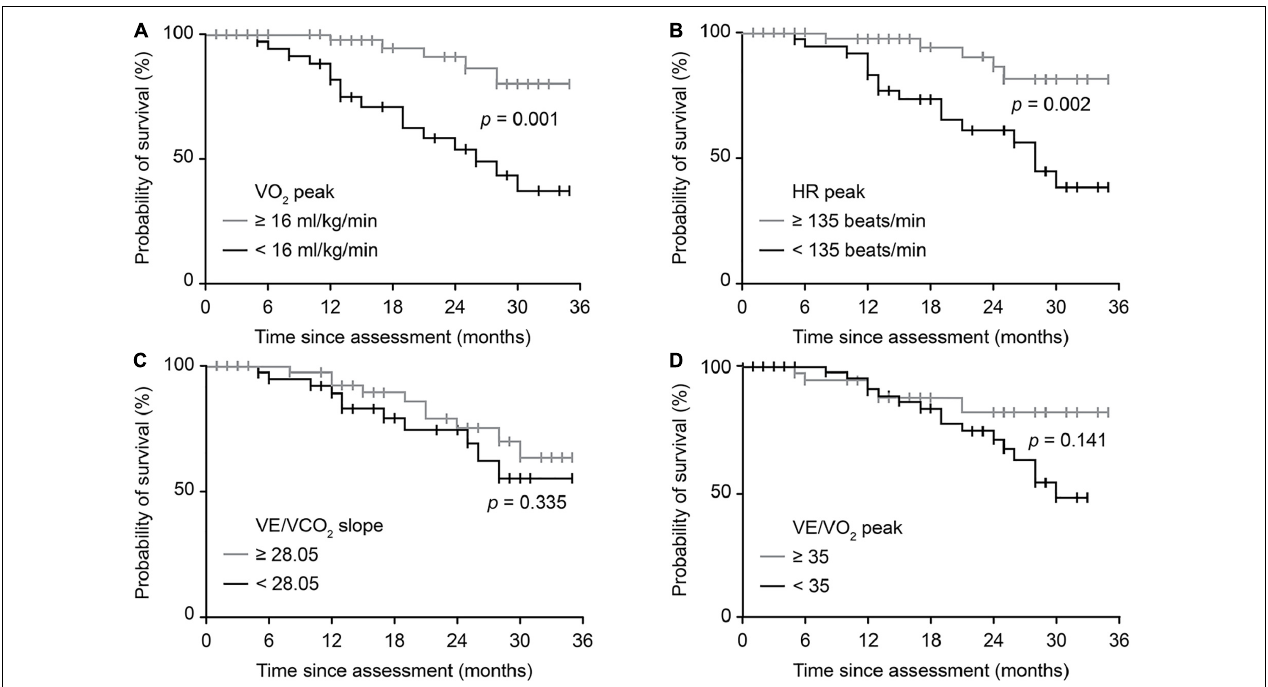
FIGURE 4 | Survival probability predicted by typical CPET variables. Crude Kaplan-Meier curves during follow-up for (A) overall exercise capacity, represented by the VO 2 peak, (B) cardiovascular function, represented by HR peak, (C) pulmonary function, represented by VE/VCO 2 slope, and (D) breathing economy, represented by the VE/VO 2 peak. The cutoff value for the VO 2 peak was defined by previous studies. The cutoff values for the remaining three variables were based on the medians of patients in this study. |, censored patients. ALS, amyotrophic lateral sclerosis; CPET, cardiopulmonary exercise testing; VO 2 , oxygen consumption; HR, heart rate; VE, minute ventilation; VCO 2 , carbon dioxide production.